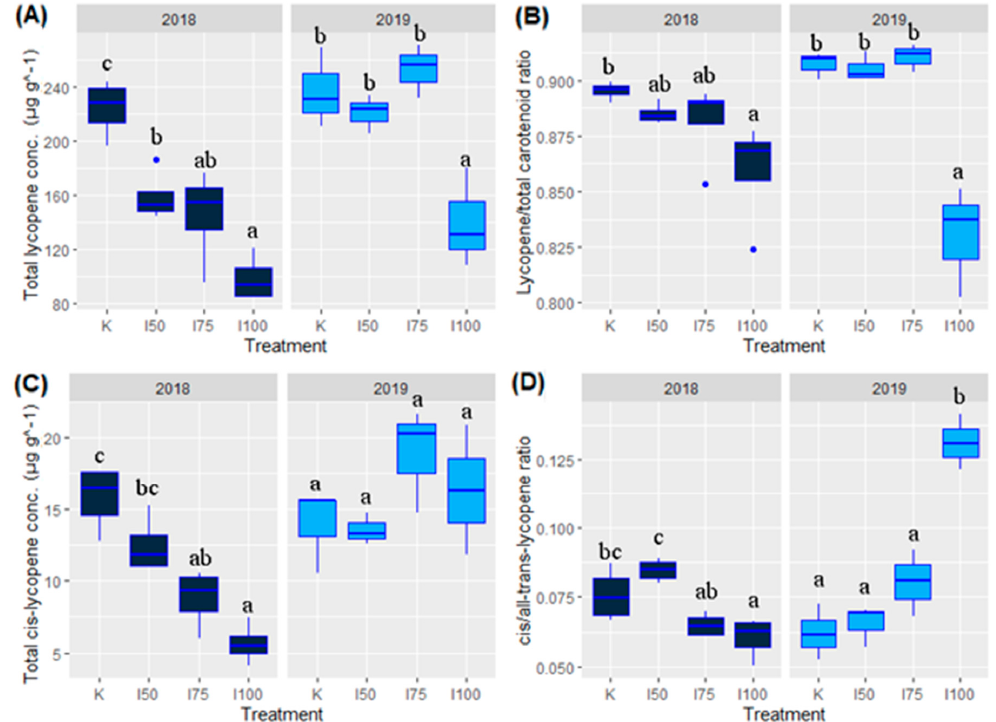
Figure 7. Average of total lycopene ( A ) and cis-lycopene ( C ) content and lycopene/total carotenoid-( B ) and cis-/all trans ( D ) lycopene ratio, under different water supply in two years. The different letters above the boxes indicate statistical differences between treatments inside one year ( p < 0.05).